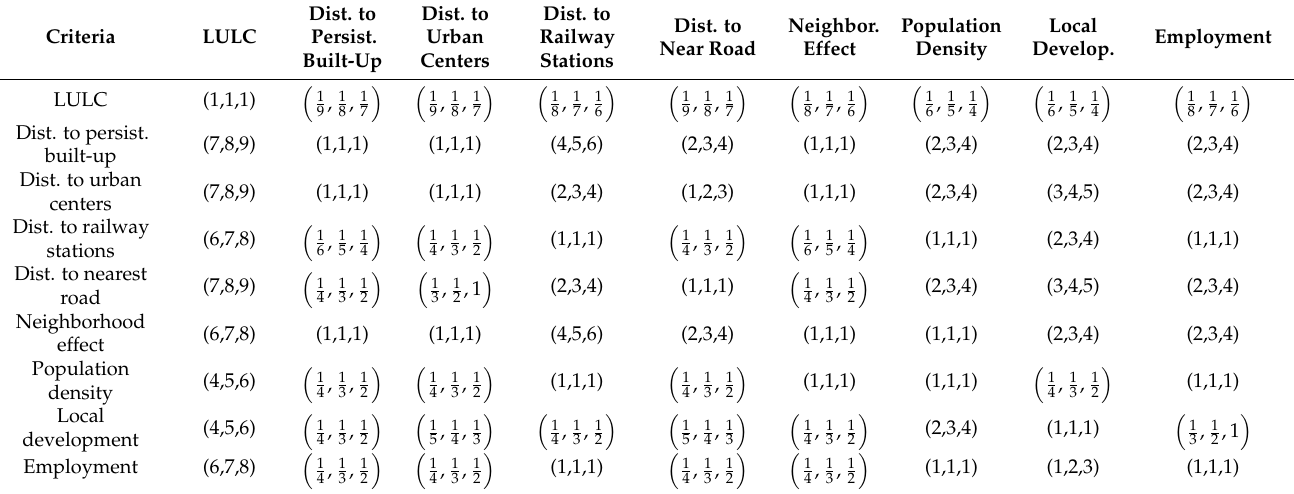
Table 2. The fuzzified pairwise comparison matrix of nine criteria selected for the study